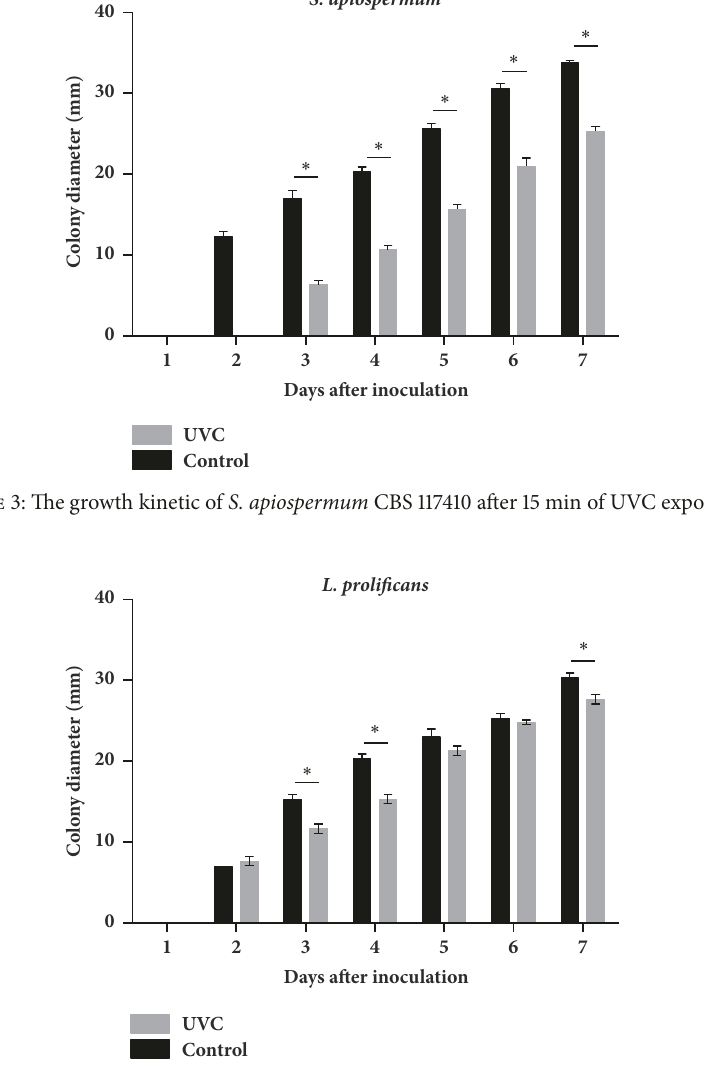
Figure 4: The growth kinetic of L. prolificans CM324after 15 min of UVC